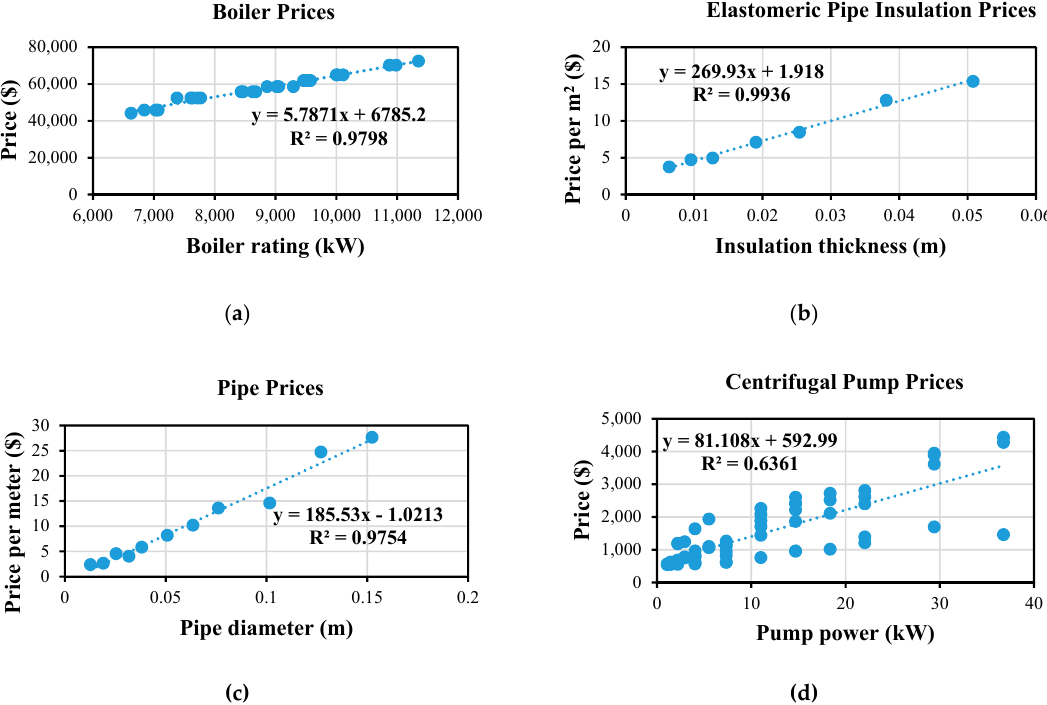
Figure 11. Equipment prices: ( a ) boiler prices in dollar currency for different heating loads (kW); ( b ) price of elastomeric insulation for different thickness per square meter in dollar currency; ( c ) pipe prices for different diameters; and ( d ) pump prices for different powers (kW).